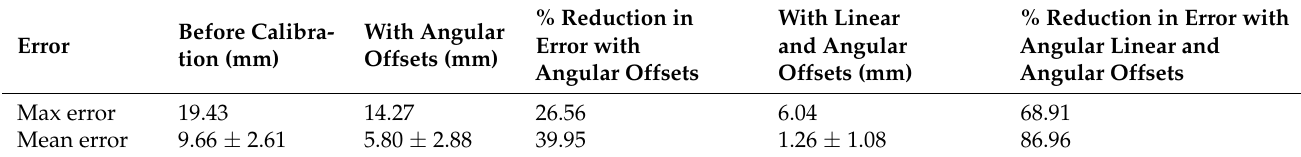
Table 9. Resultant position error before and after